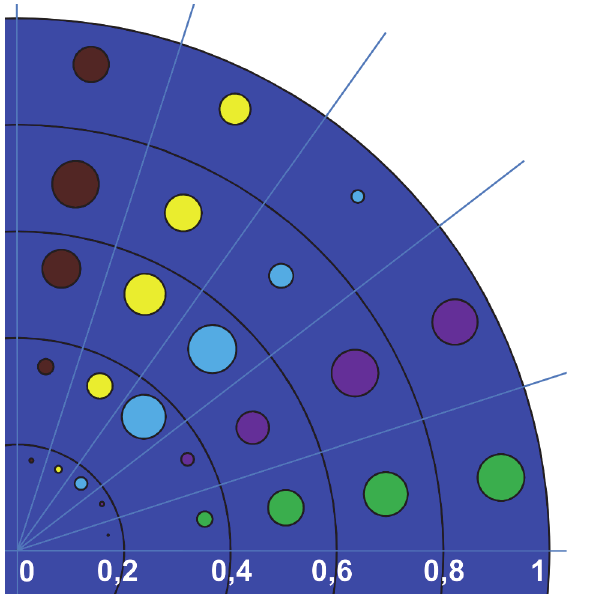
Fig 6. Schematic distribution of RDCs of HSA12, HSA18, HSA6 и HSAX in MSC nucleus. The sizes of the colored circles show the frequency of finding the centromere in the particular radial interval. Braun — HSA6, yellow — HSA12, light-blue — HSA18, violet — HSAX (female), green — HSAX (male).